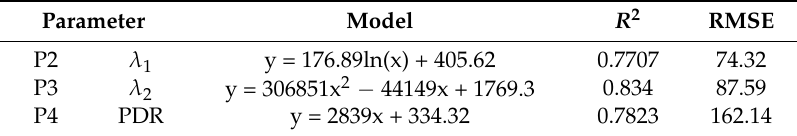
Table 8. The best models for biomass inversion at the P2, P3, and P4 stages Table8. The best models for biomass inversion at the P2, P3, and P4 stages Parameter Model R 2 RMSE Parameter Model R 2 RMSE PDR